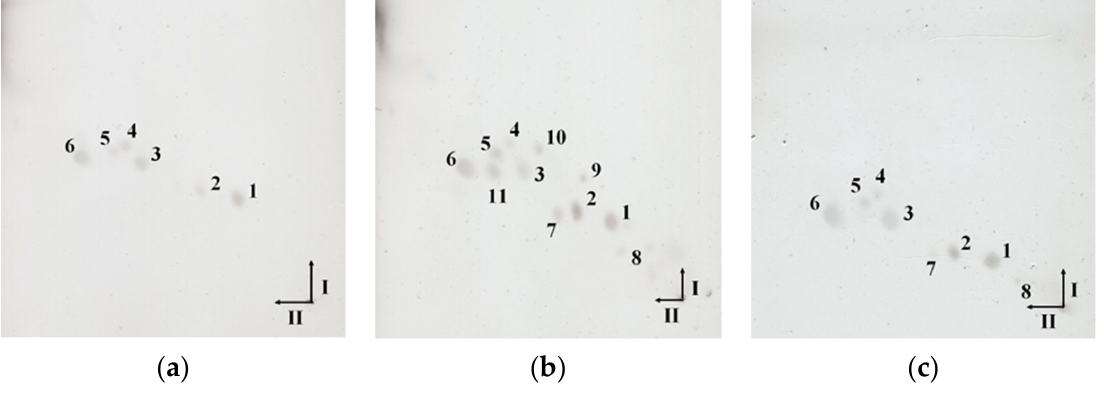
Figure 4. 2D-TLC lipid profiles of EVs: ( a ) C. acnes DSM 1897 type IA1, ( b ) C. acnes DSM 16379 type IB, and ( c ) C. acnes PCM 2334 type II. The black arrows (I and II) indicate the directions in which the chromatograms were developed. The lipids visible on the plates are numbered in the range 1–11. The TLC was developed in (I) chloroform-methanol-water (65:25:4, v / v ), II chloroform-methanol-acetic acid-water (80:15:12:4, v / v ), and for the detection of lipids, copper sulfate reagent and heating at 130 °C were applied.